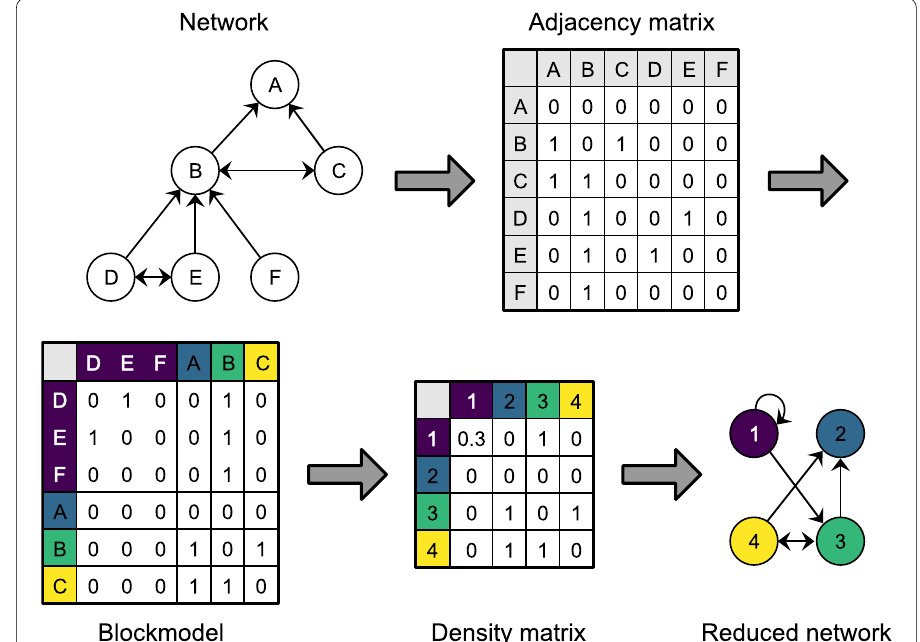
Fig. 3 Simplified example of the process of partitioning a network into